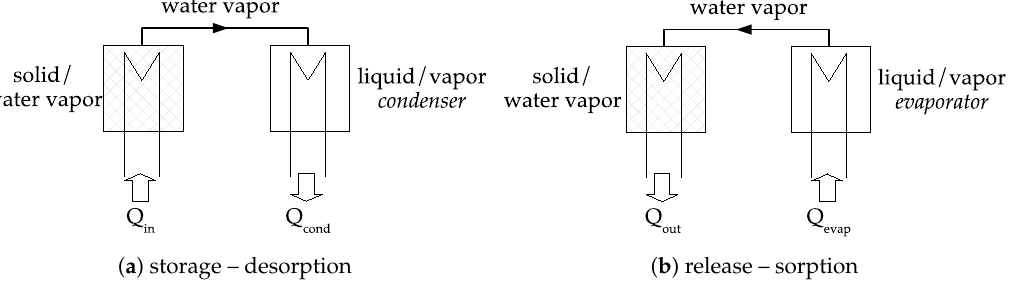
Figure 4. Closed heat storage system—quantities refer to Figure 3—reproduced from [1], copyright permission: Elsevier,